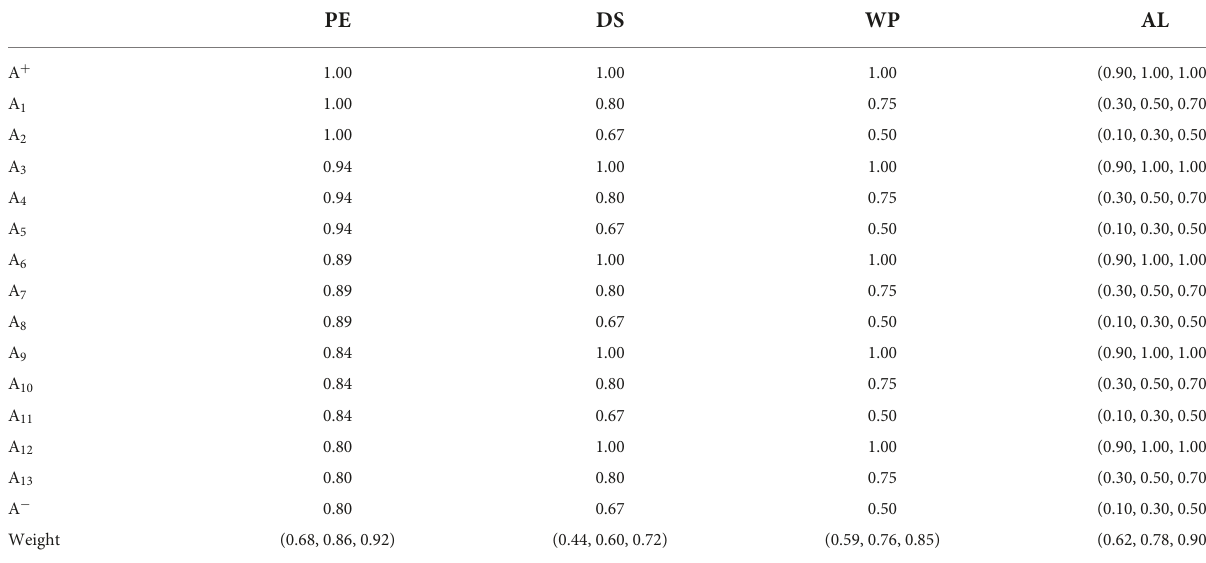
TABLE 8 The normalized fuzzy decision matrix.